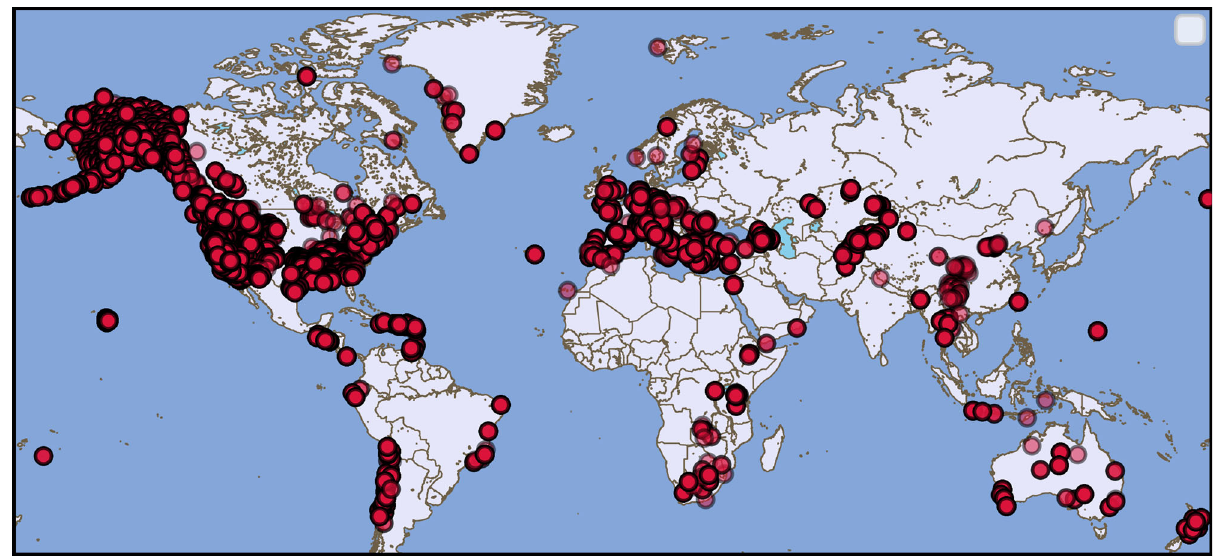
Fig. 2 The training and test dataset. Geographic distribution of station locations recording 300 k noise and 1 M earthquake seismograms in STanford EArthquake Dataset (STEAD) used in this